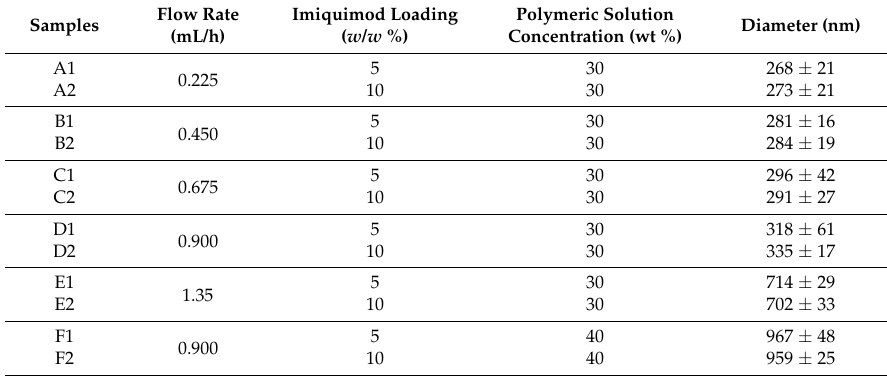
Table 2. Parameters of the prepared imiquimod-poly( ε -caprolactone) nanofibrous meshes employed in determination of the drug release